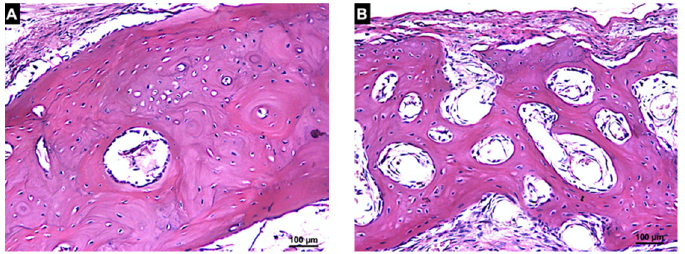
Figure 11. Histologic photomicrography of the Base region in the autogenous ( A ) and xenogenous ( B ) grafts after 60 days of healing. The autogenous bone was remodeled and presented secondary osteons with rare empty lacunae. The new bone in the xenografts was mainly represented by primary osteons. Small amounts of the remnants of the xenograft were detected. Hematoxylin and eosin stain; magnification 200×.